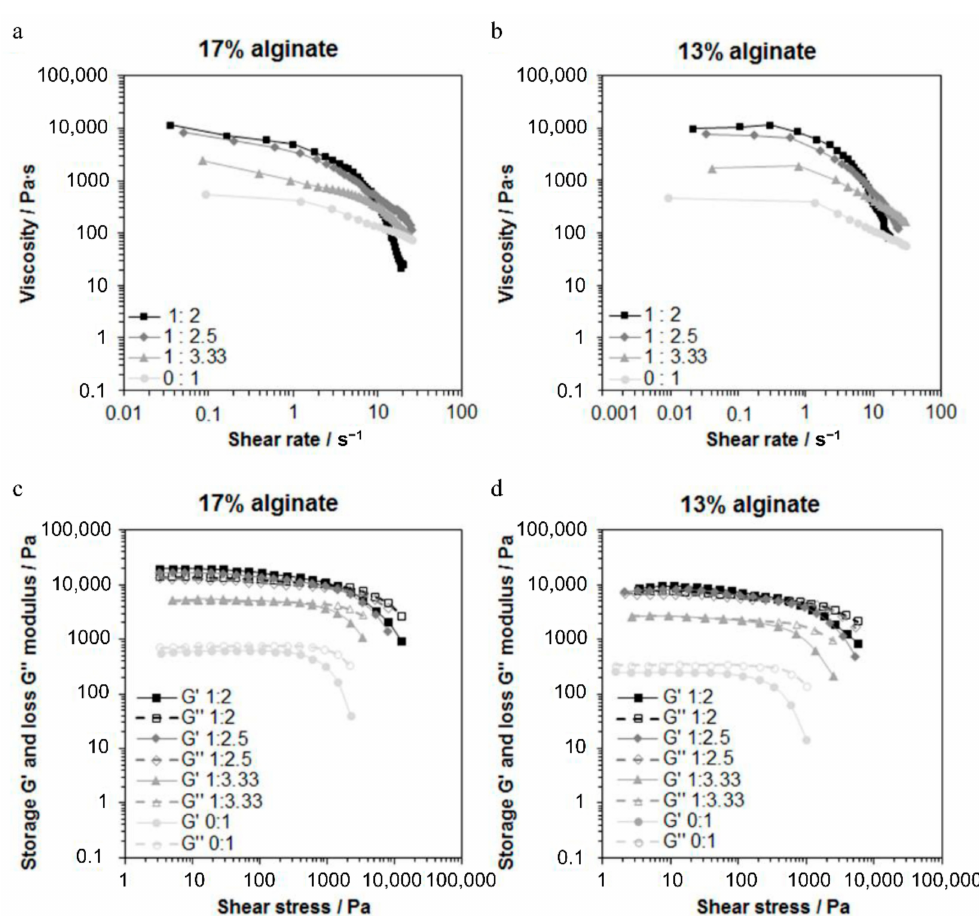
Figure 2. Rheological properties of Xerogel/Alg pastes. ( a , b ) Viscosities of Xerogel/Alg pastes with Xerogel/Alg ratios 1:3.33, 1:2.5, and 1:2, as well as of pure alginate (0:1) at 17 wt.% ( a ) and 13 wt.% ( b ) alginate concentration, respectively, for different shear rates. ( c , d ) Amplitude sweep measurements of Xerogel/Alg pastes with Xerogel/Alg ratios at 17 wt.% ( c ) and 13 wt.% ( d ) alginate concentration, respectively, for different shear